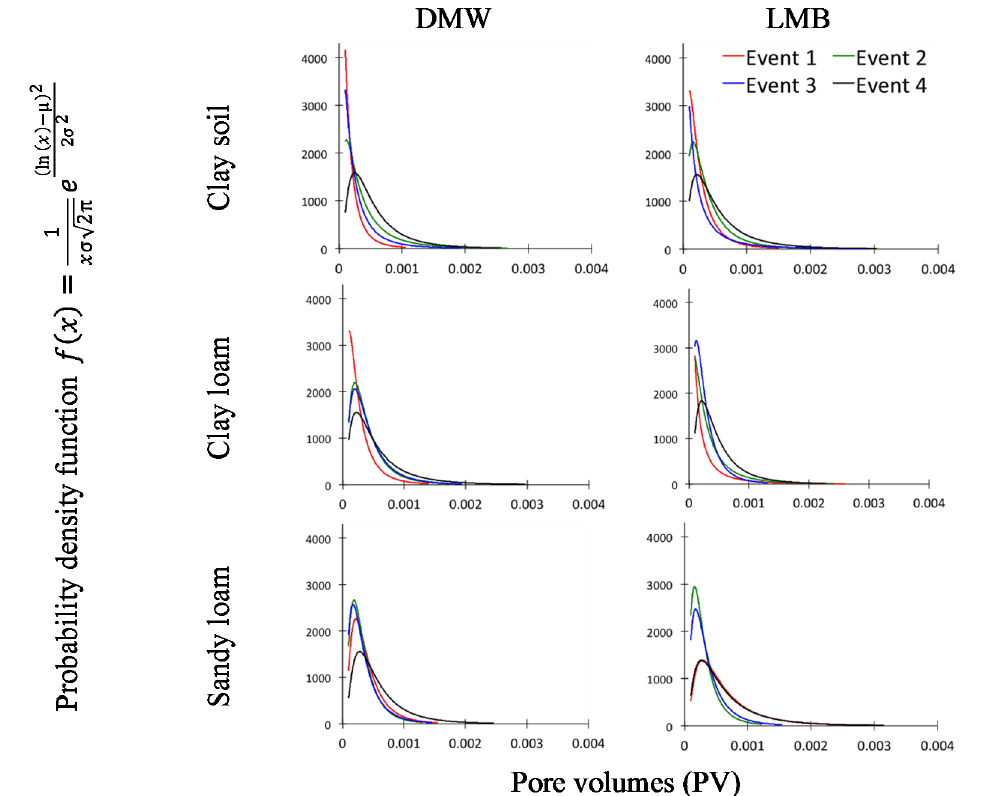
Figure 4. Distribution of drainage water flow volumes. Log-normal distributions ( μ , σ ), maximum-likelihood best fit